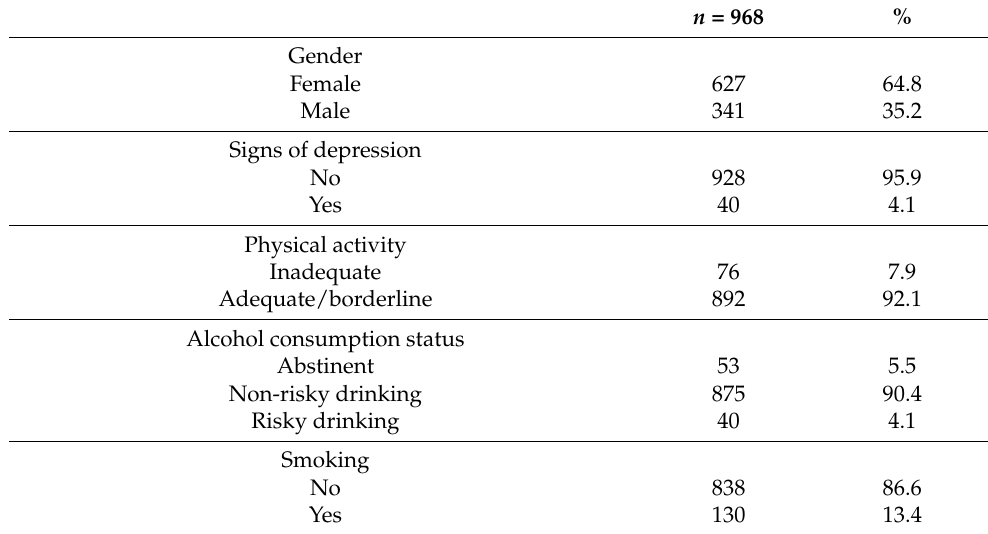
Table 1. Characteristics of